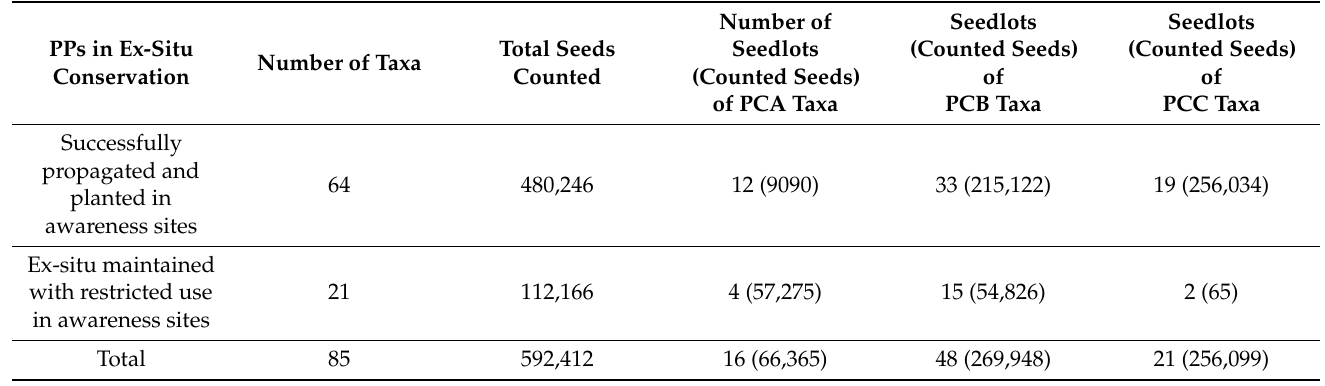
Table 5. Overview of seedlots and ex-situ stored in the Balkan Botanic Garden of Kroussia from priority plants (PPs) of different categories (PCA, Threatened and Near Threatened; PCB, Local Balkan endemics and subendemics; PCC, Regionally rare and/or uncommon plants). Seedlots Seedlots Number of (Counted Seeds) (Counted Seeds) Seedlots Total Seeds of (Counted Seeds) Counted PCB Taxa of PCA Taxa